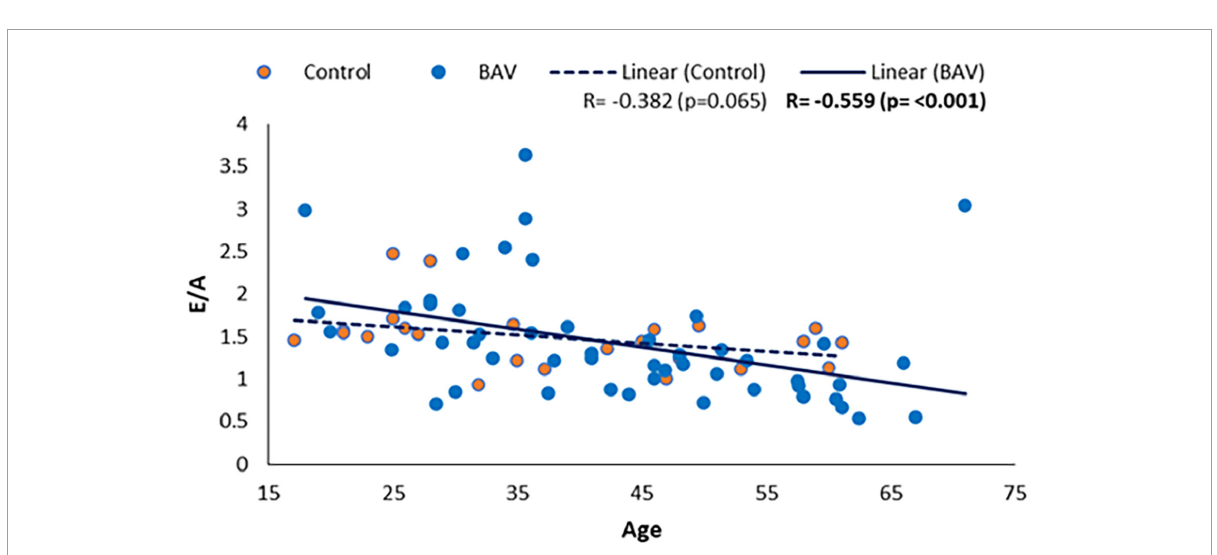
FIGURE8 E/A correlation with age in healthy and BAV groups. BAV has a statistically significant correlation with age rather than with healthy